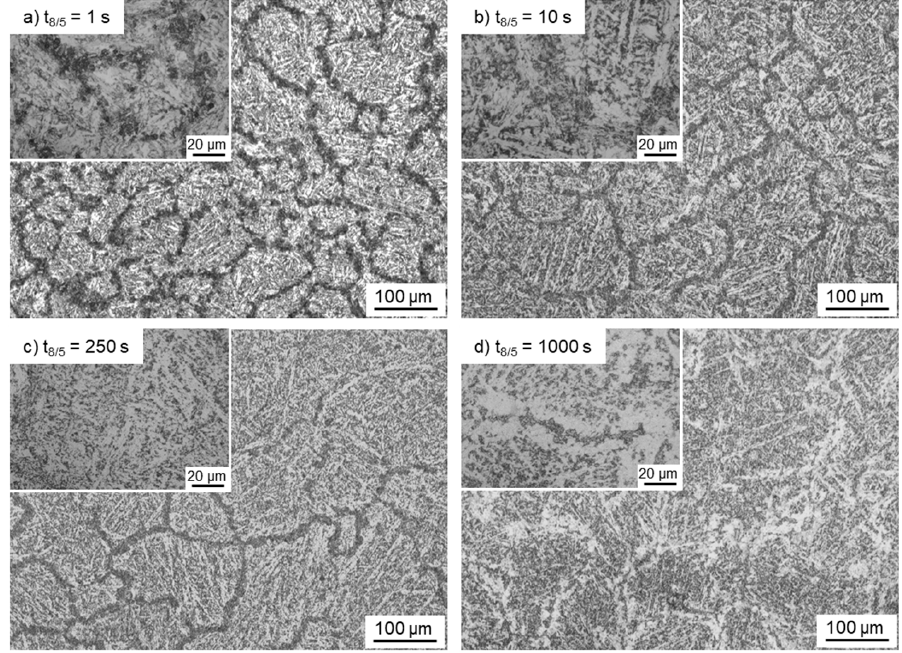
Figure 10. OM images of the microstructure of the dilatometer specimens heated to 850 °C peak temperature and cooled with different t 8/5 -times of ( a ) 1 s; ( b ) 10 s; ( c ) 250 s; and ( d ) 1000 s at lower and higher magnification.